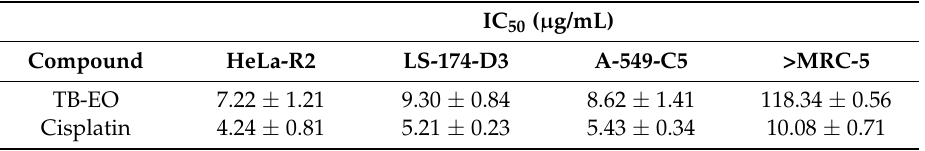
Table 3. Cytotoxic effect of TB-EO on human cancer cell lines.